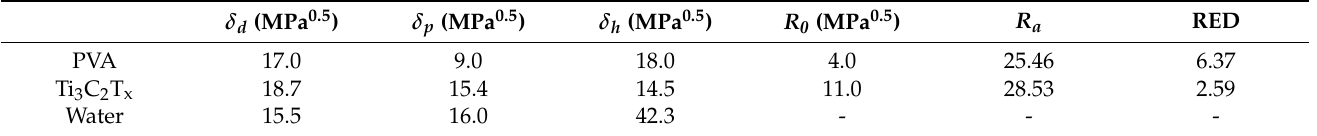
Table 3. Hansen’s solubility parameters for the PVA and MXene (Ti 3 C 2 Tx) and distance parameter ( R a ) and RED calculated according Equations (7) and